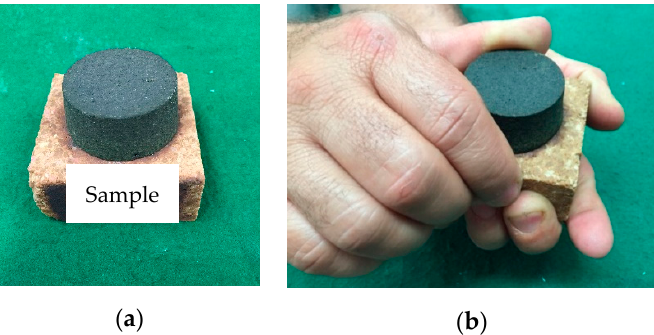
Figure 1. Assemblage for contact coating test used in the present work. ( a ) Cylindrical coating agent placed on the sample surface before the test. ( b ) Attempt to remove the coating agent from the sample after the test.